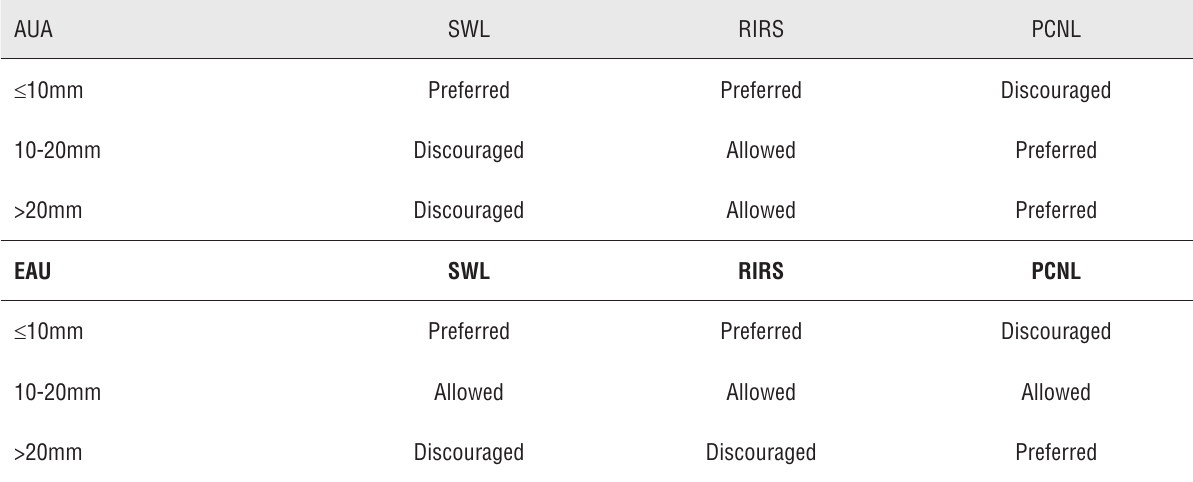
Table 1 - Recommendations for the surgical management of lower pole stones based on current AUA and EAU guidelines. AUA SWL ≤